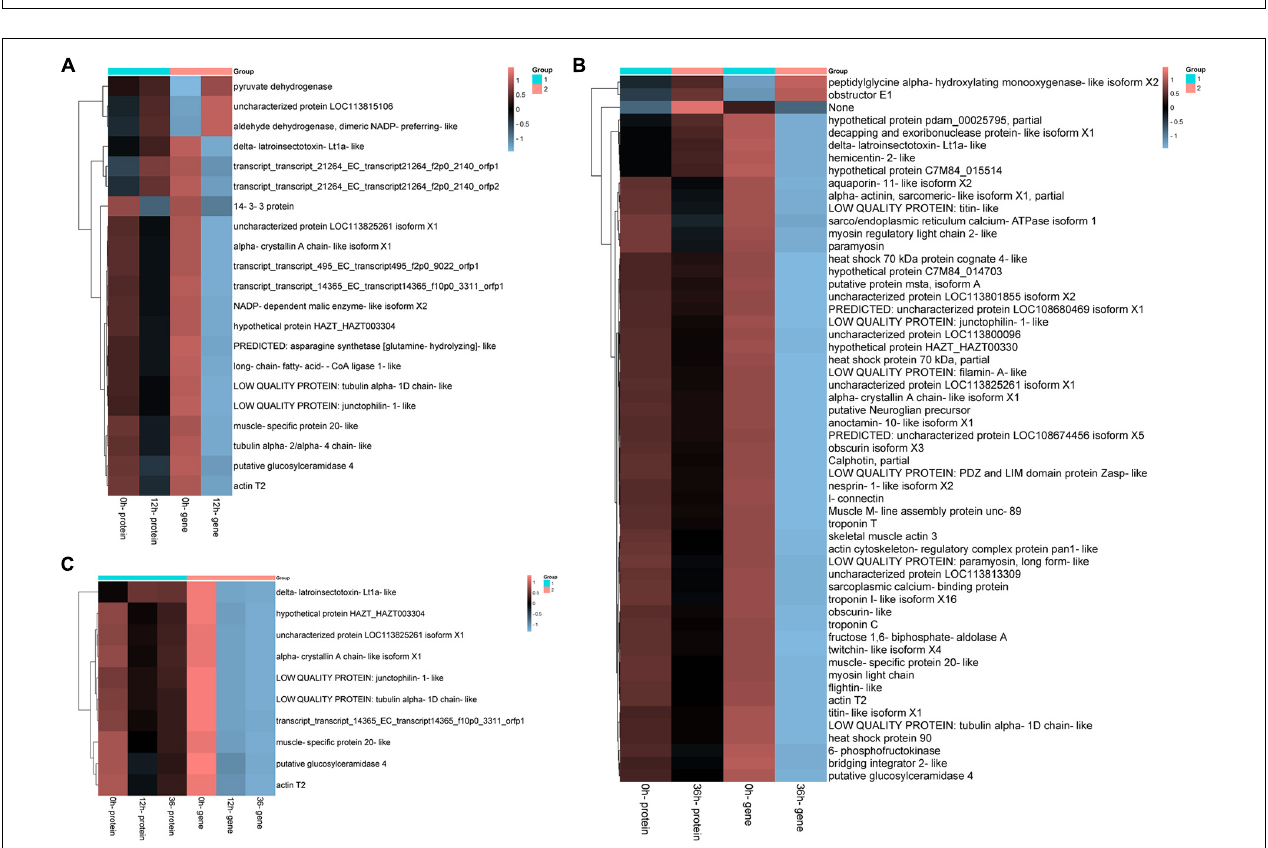
FIGURE 8 | Differentially expressed genes (DEGs) and differentially expressed proteins (DEPs) distribution in transcriptome and proteome association analysis. (A) The differences between 0 vs. 12 h correlated data were up-regulated and down regulated DEGs and DEPs. (B) The differences between 0 vs. 36 h correlated data were up-regulated and down regulated DEGs and DEPs.